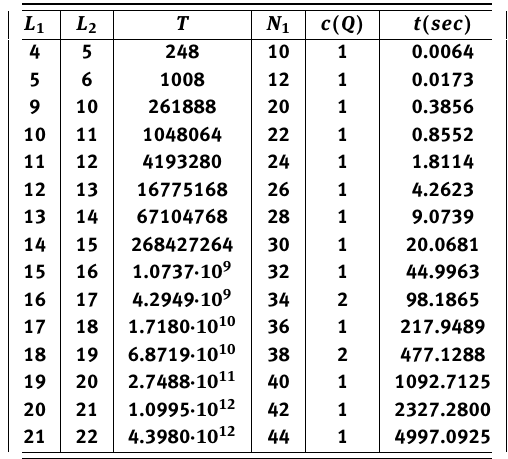
Table 1. Numerical results for the algorithm